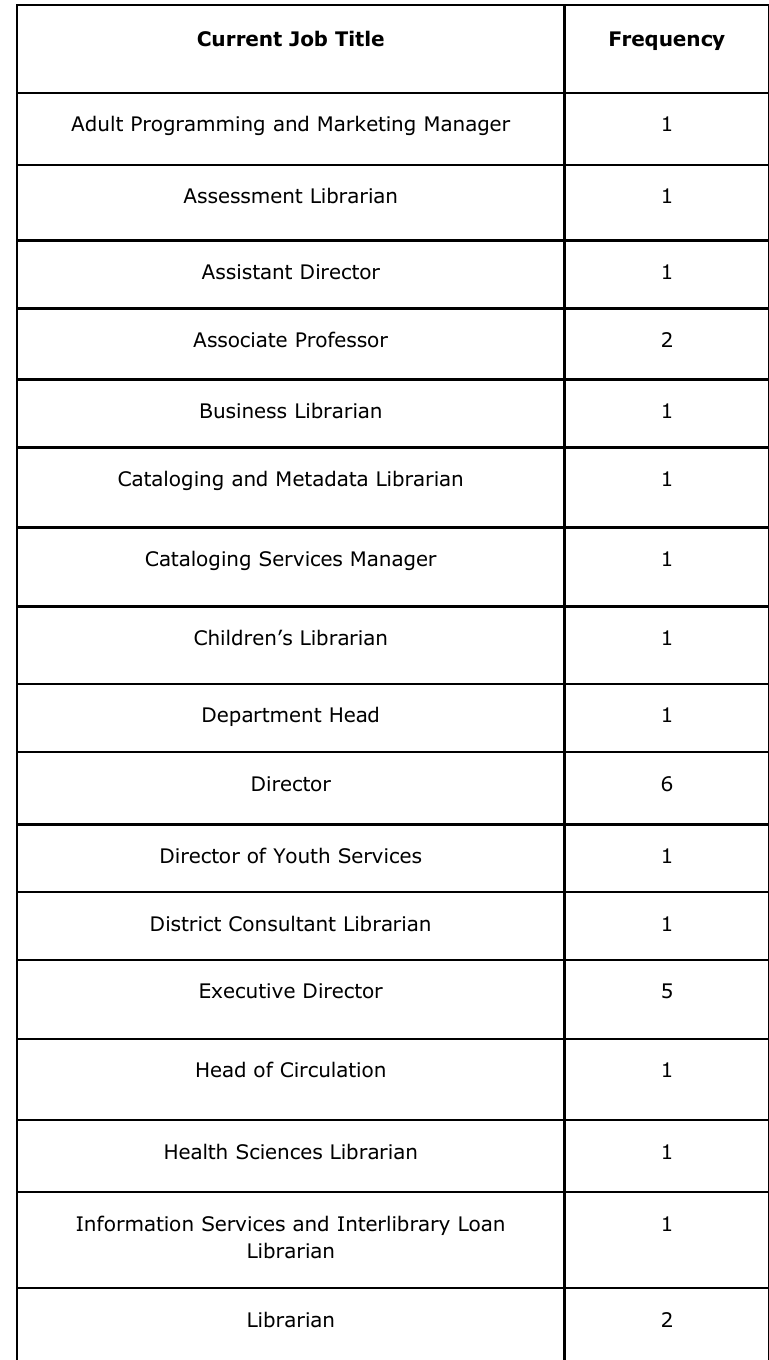
Current Job Title Frequency Distribution (N=40)